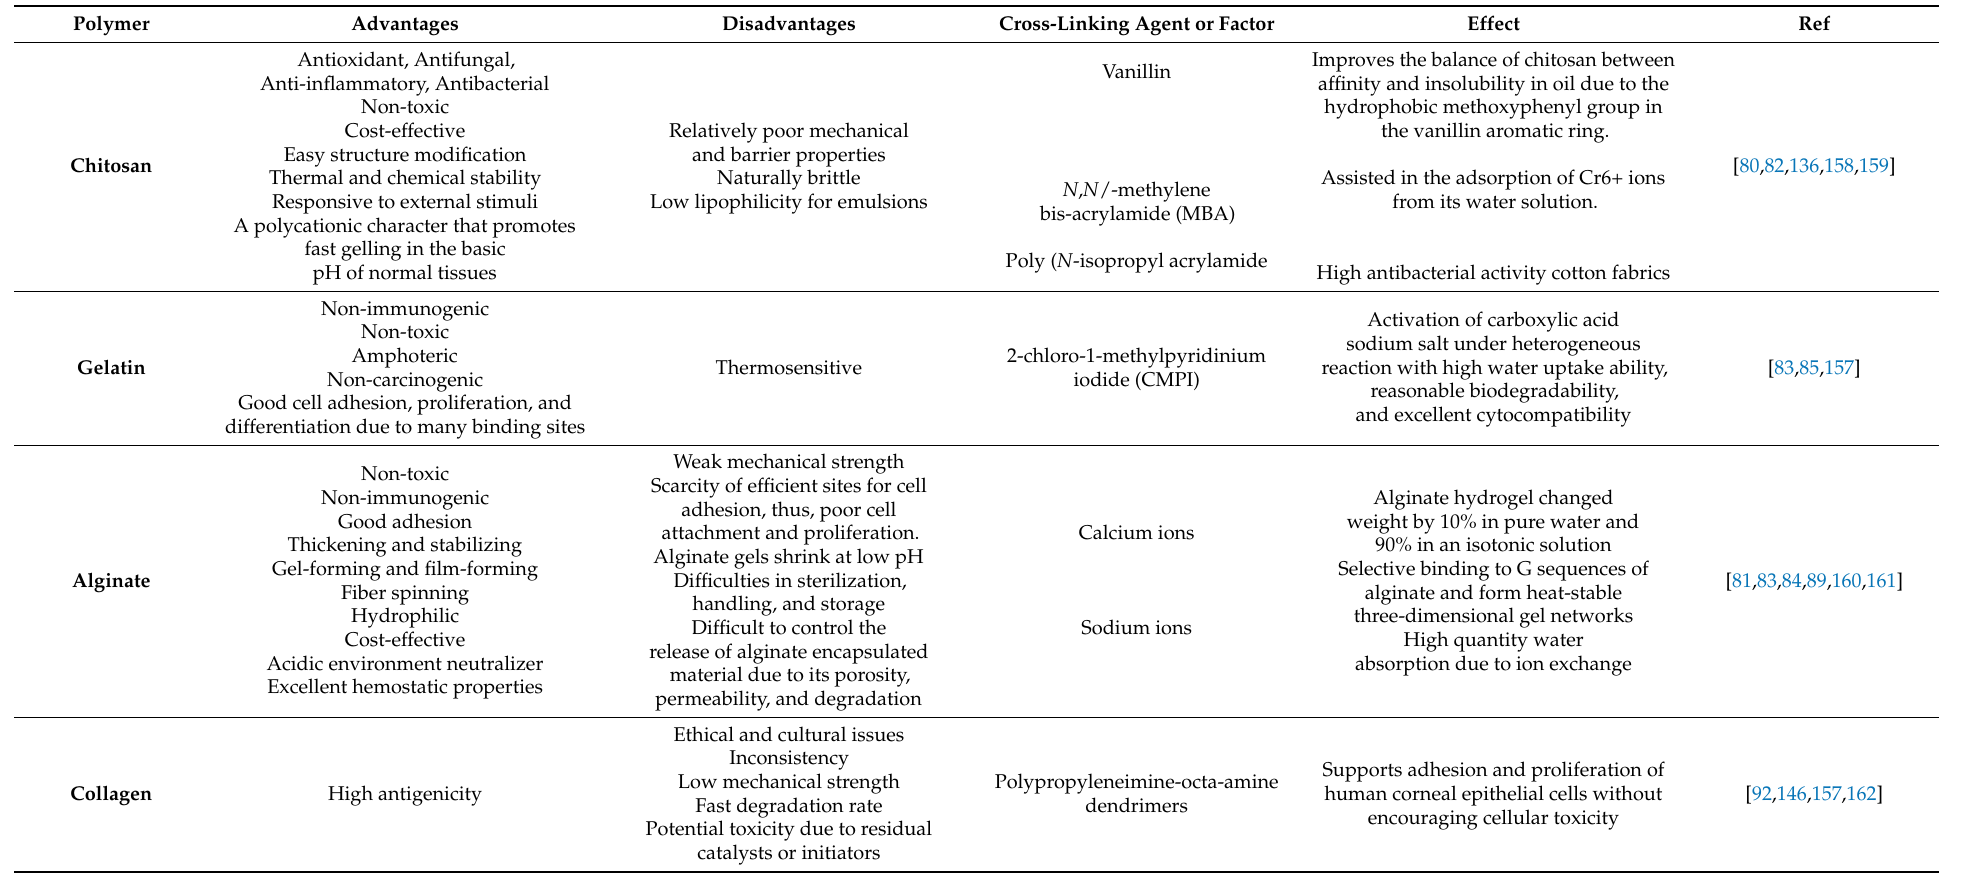
Table 2. A summary of natural polymers, advantages, disadvantages, crosslinkers cross-linking agents or factors used and their effect.